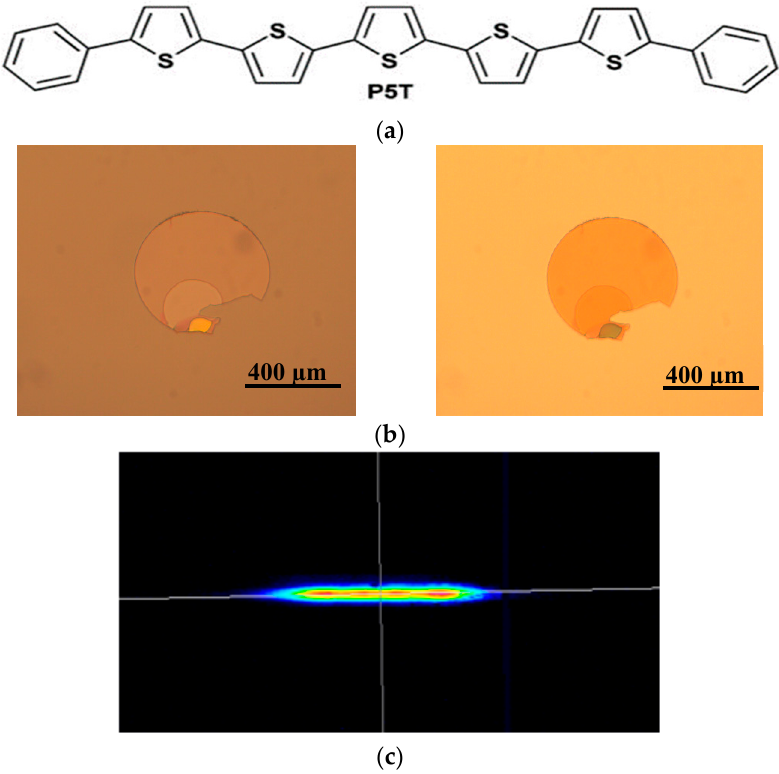
Figure 1. ( a ) Molecular structure of P5T ( b ) optical micrographs of P5T crystals at different optical polarizations ( c ) femtosecond laser excitation beam profile/spot size.